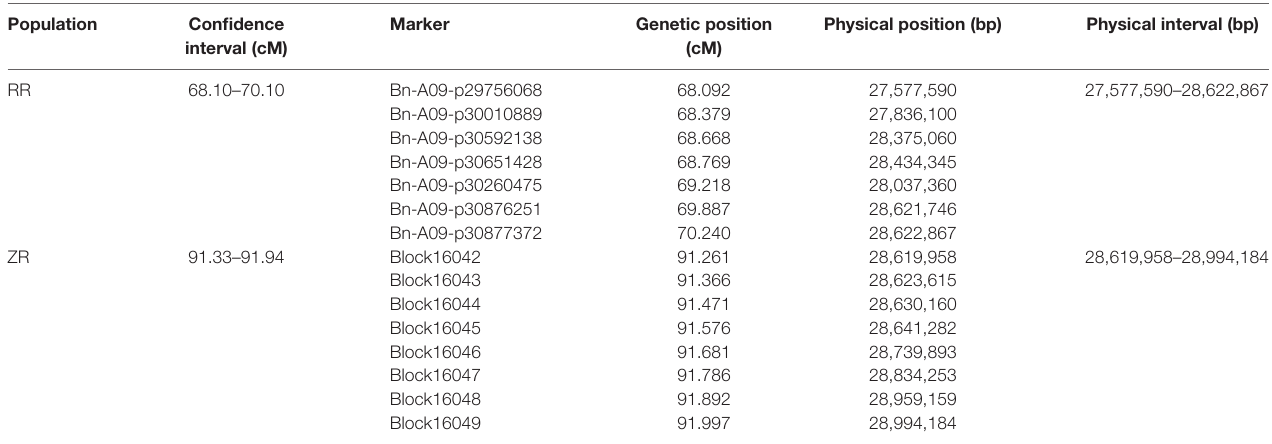
TaBLe 5 | Physical position analysis of the bin markers within the confidence interval of qSL.A09 .